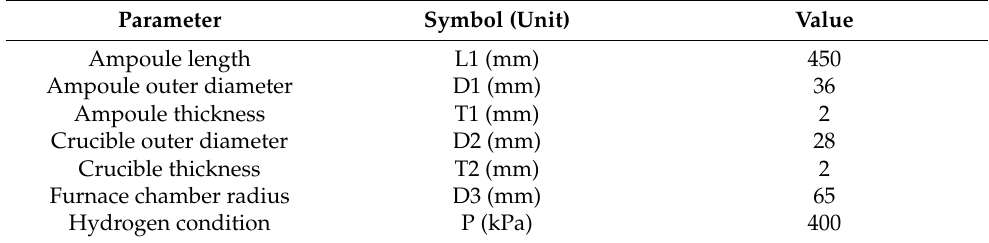
Figure 4. Valuable physical property data used in simulation. Table 1. Parameters of crystal growth system.